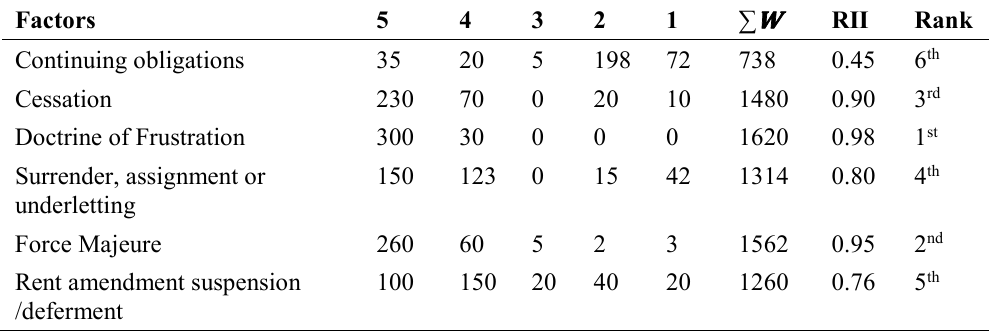
Table 4. Relative Importance Index of Factors/Clauses Determining